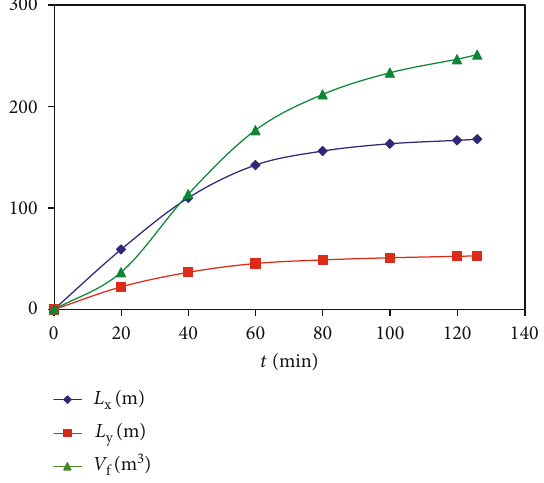
L V x , y , and f with